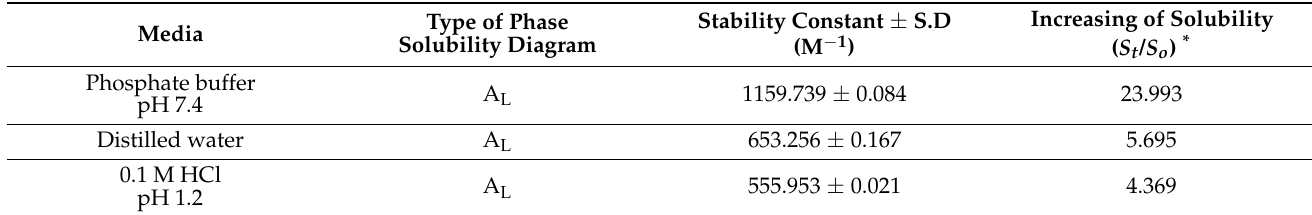
Table 1. Summary results of phase solubility studies of the ME-